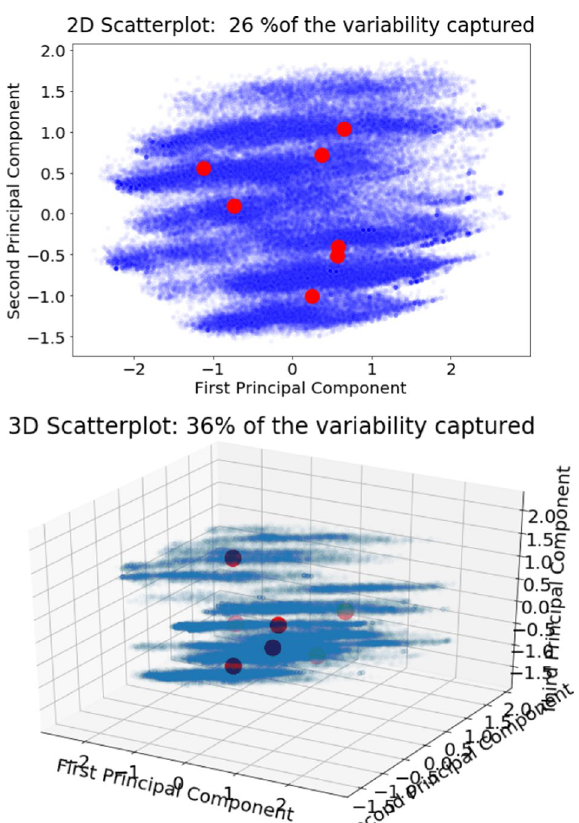
Fig. 8 Two-dimensional and three-dimensional visualisations with centroids of seven clusters ( k